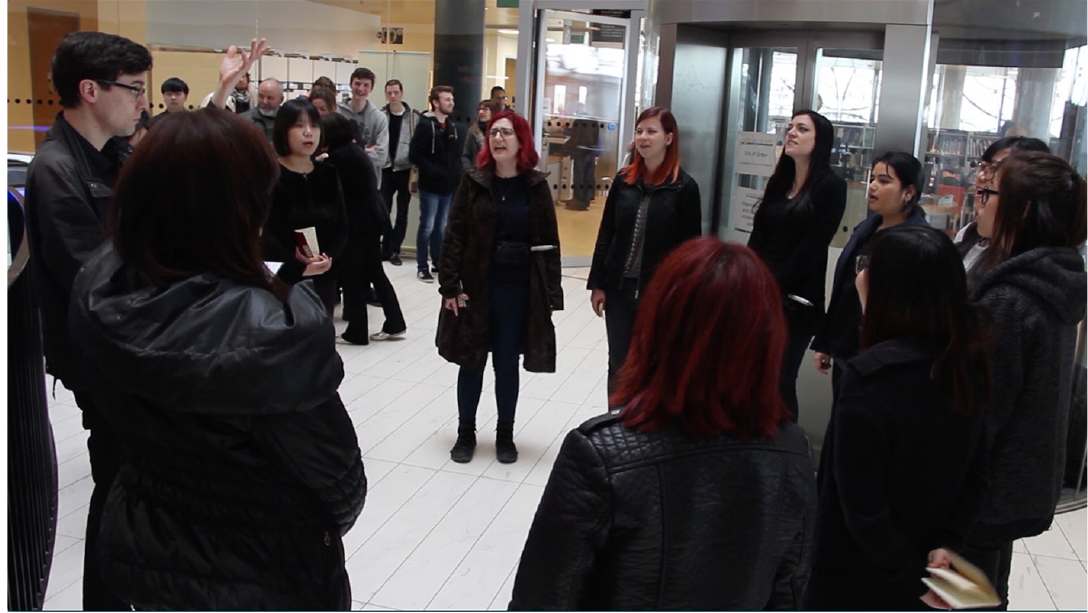
Figure 6. Translation Zone(s): A Stuttering (2016). Digital video still of participants performing on level 4 at the entrance to the cylindrical tower that ascends to the top of the Library of